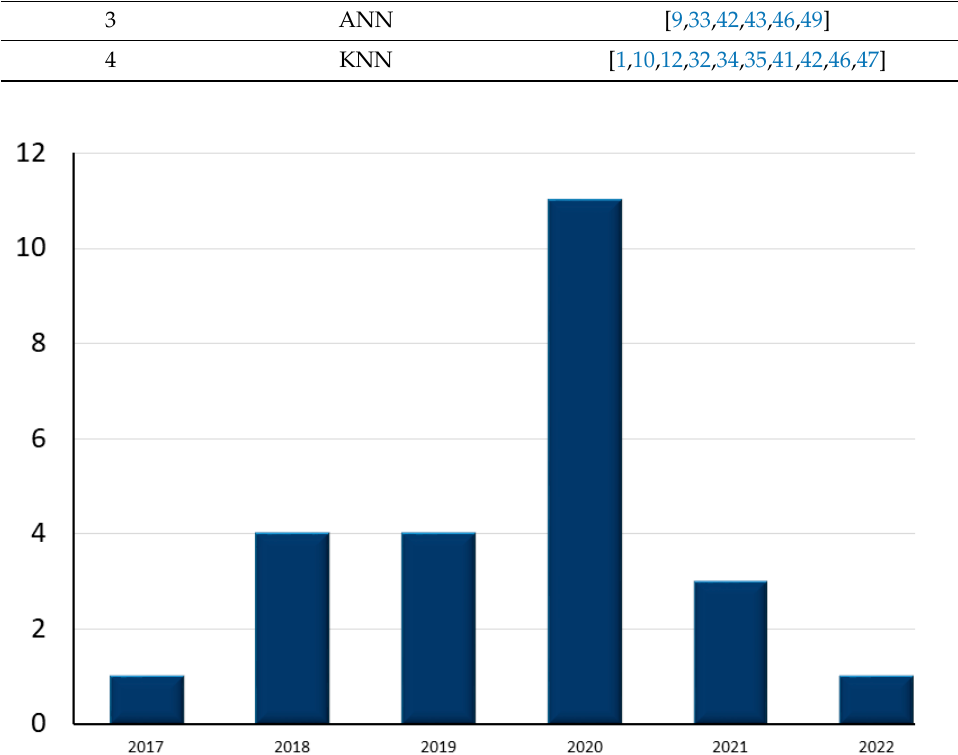
Figure 4. Publication frequency of studies based on selected years . Table 9. ML classifiers used in the selected articles .